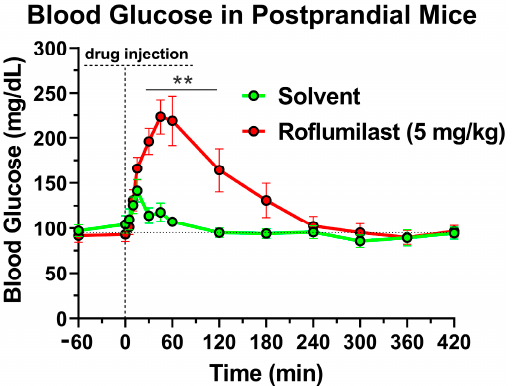
Figure 1. Acute treatment with the PAN-PDE4 inhibitor roflumilast induces a transient increase in postprandial blood glucose levels. The graph shows blood glucose levels, measured with glucometer test strips at tail pricks in postprandial mice that had been deprived of food for 5 h prior to treatment with the PAN-PDE4 inhibitor roflumilast (5 mg/kg; intraperitoneal (i.p.) injection) or solvent controls. The data represent the mean ± SEM of n = 8 mice. Roflumilast significantly increased blood glucose levels (**, p < 0.01) compared to solvent controls, as determined by a two-way ANOVA with Sidak’s post hoc test.